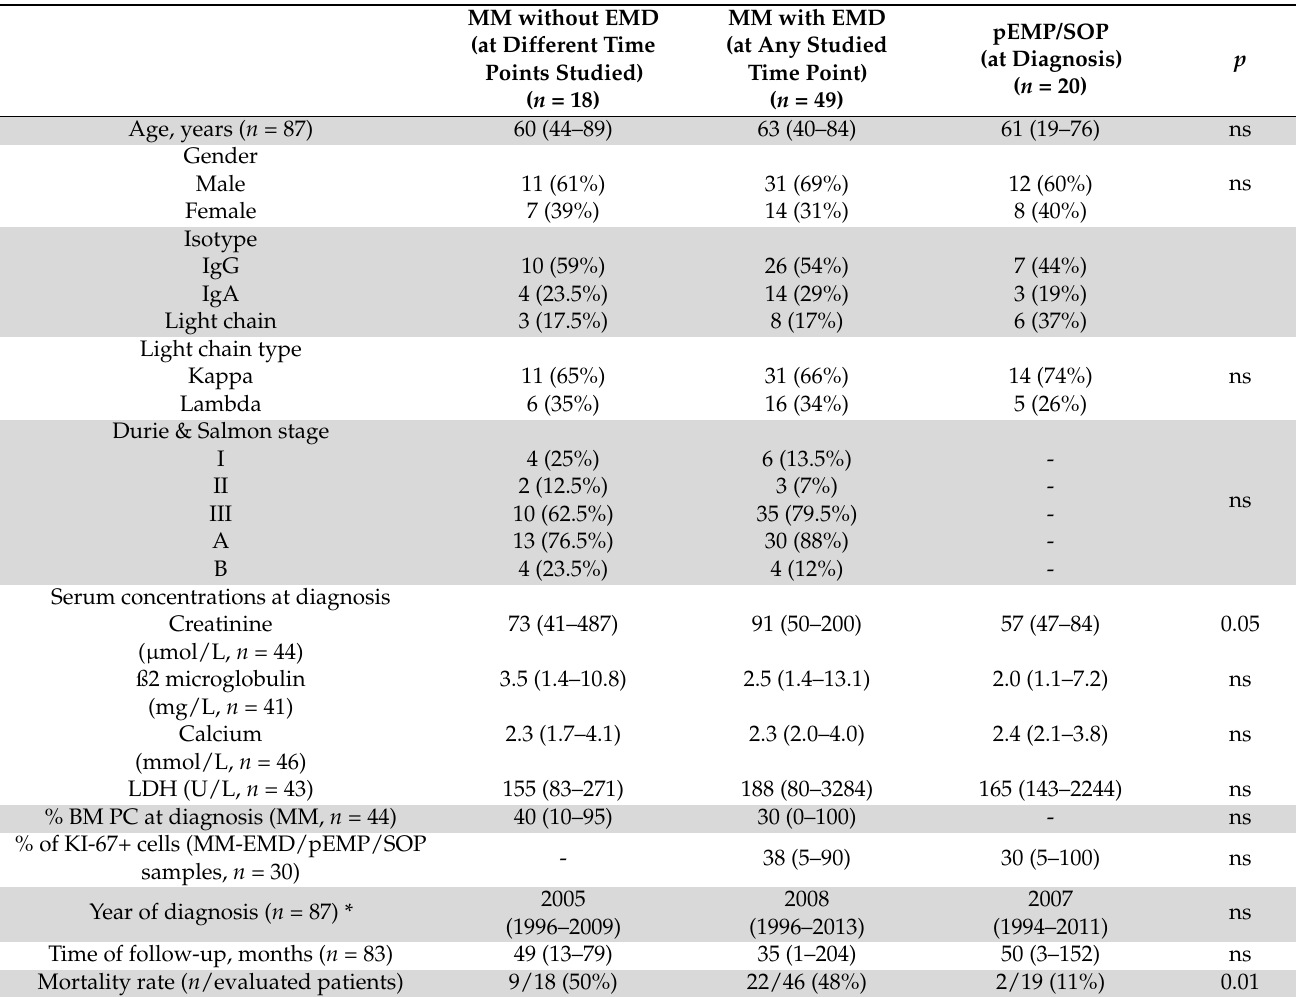
Table 1. Patient characteristics. Shown are numbers ( n ) of evaluable patients and percentages (%) or median values with ranges and evaluated patients,